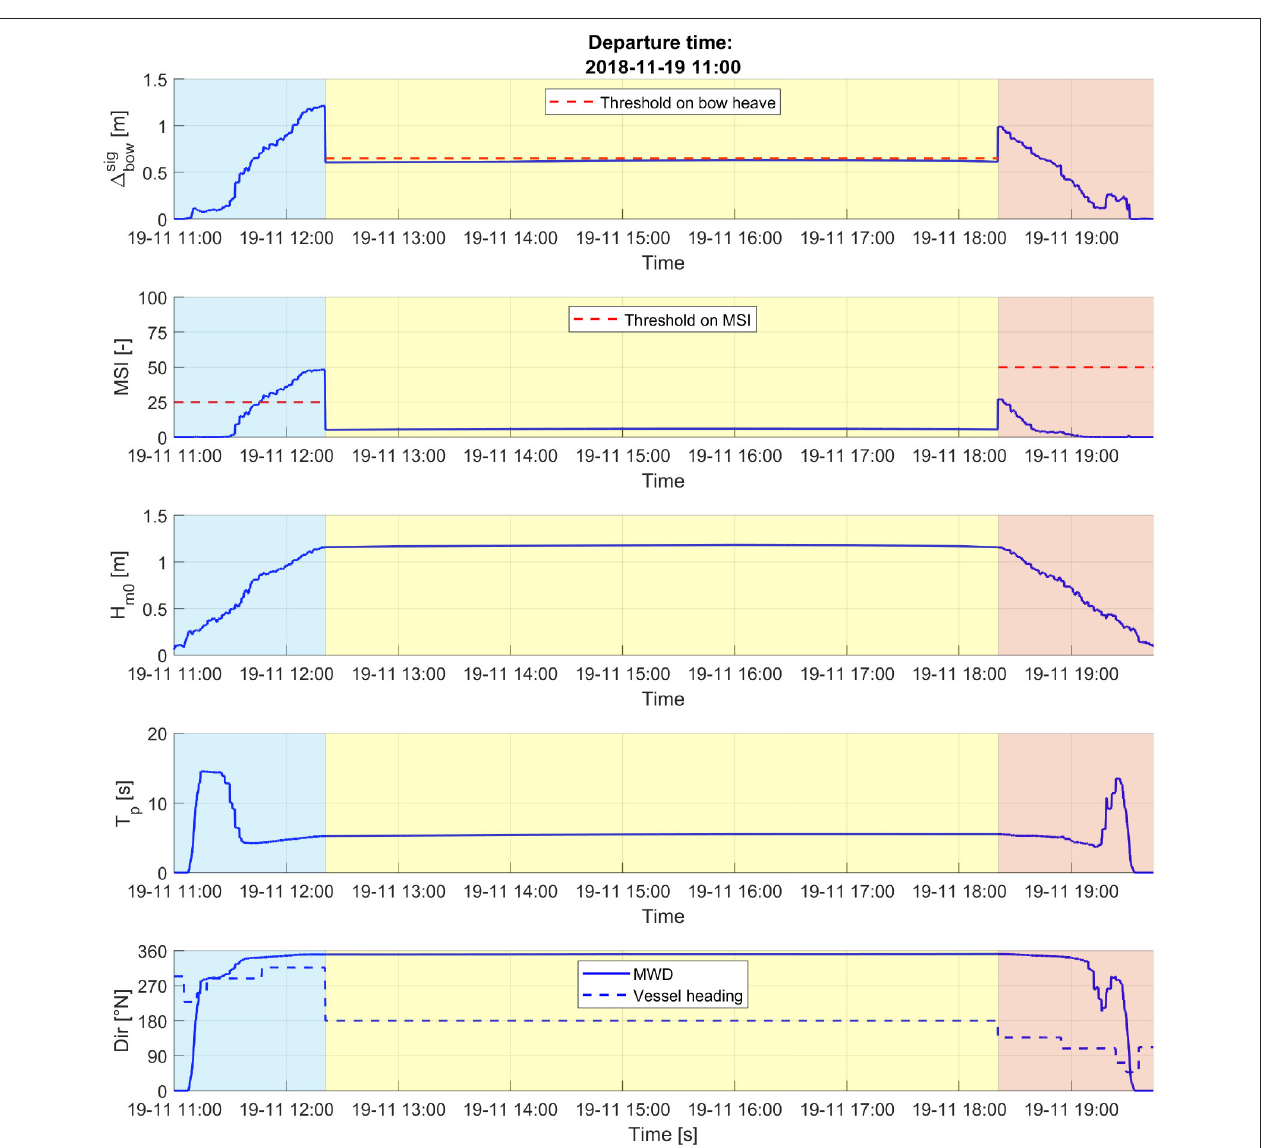
FIGURE 9 | Output for the trip departed on the 19th of November 2018 at 11:00. From top to bottom panel: significant vertical displacement of the vessel bow ( 1 sig bow ), Motion Sickness Incidence (MSI), combined significant wave height (sea and swell), swell peak wave period, and swell mean wave direction. Bottom panel displays also the CTV direction. In each plot, the time window for each phase is marked with a different color, i.e., cyan for sail-out, yellow for operation, pink for